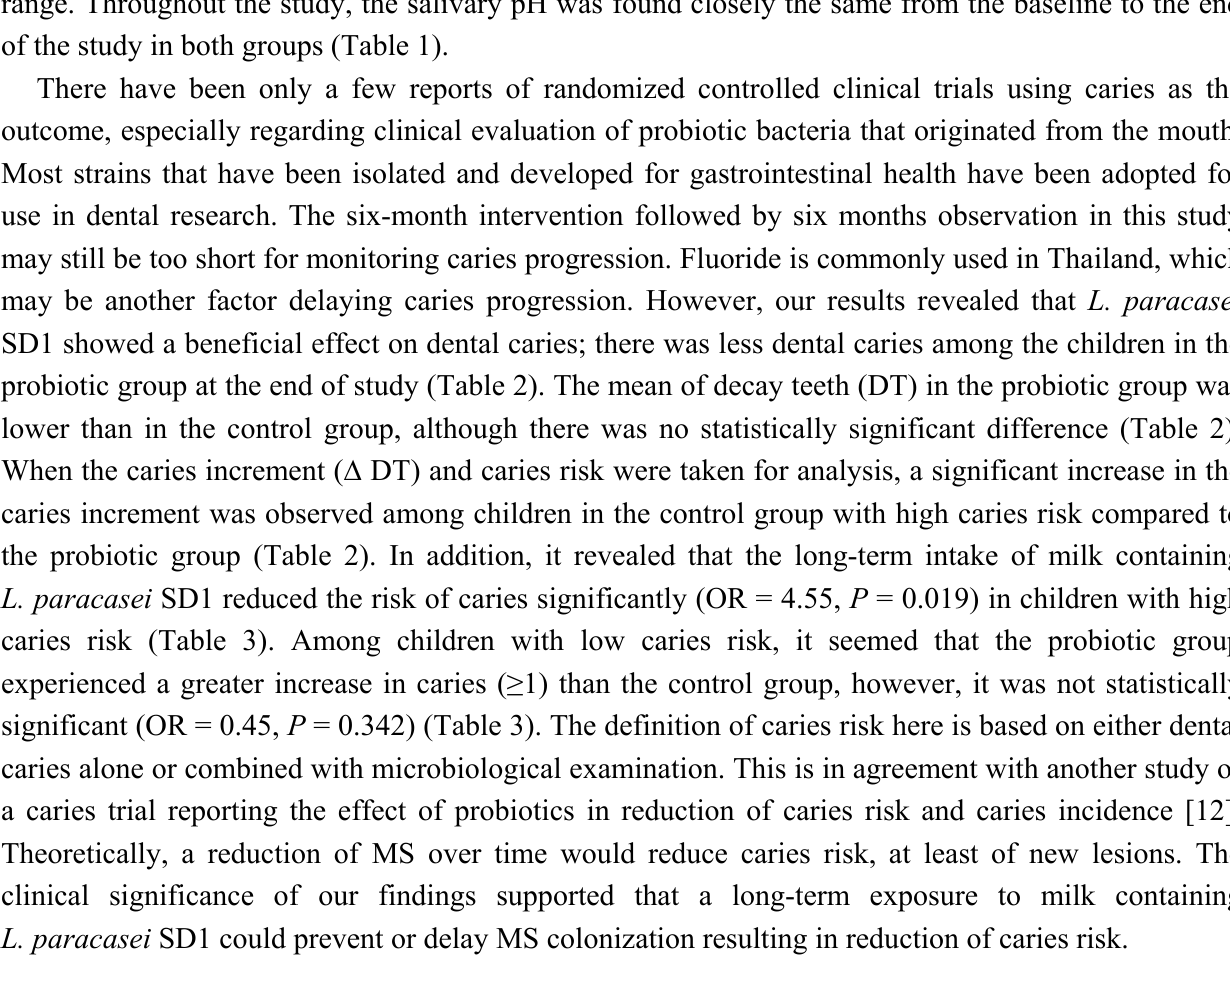
Table 2. Mean decay teeth (DT) ± SD at T0 and mean caries increments ( ∆ DT) ± SD at T12 in the control and probiotic